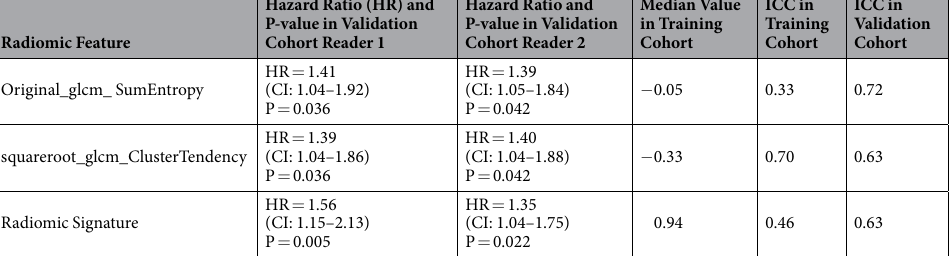
Table 3. List of hazard ratios, P-values, median values, and ICCs of significant radiomic features prognostic of OS in the training and validation cohorts. Abbreviations: CI: confidence interval; ICC: intraclass correlation; OS: overall survival: Original_glcm_SumEntropy, sum entropy feature extracted from original image via grey level co-occurrence matrix; Squareroot_glcm_ ClusterTendency: cluster tendency feature extracted from filtered image (square root) via grey level co-occurrence matrix.